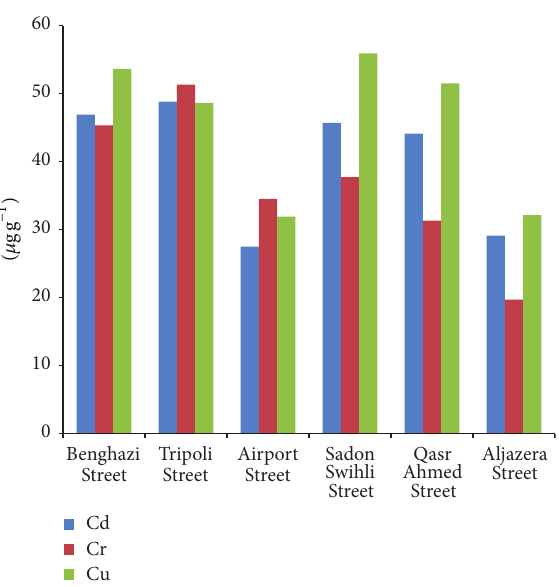
Figure 1: Concentration of pb, in soil.